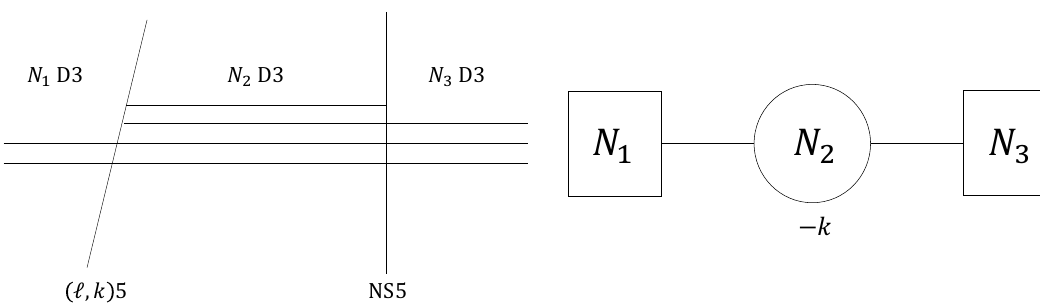
Figure 3 . [Left] The brane configuration of the local theory. Note that the horizontal direction is not identified on the both ends unlike figure 2. [Right] The quiver diagram for ‘ = 1 . For ‘ > 1 , it is non-Lagrangian theory.